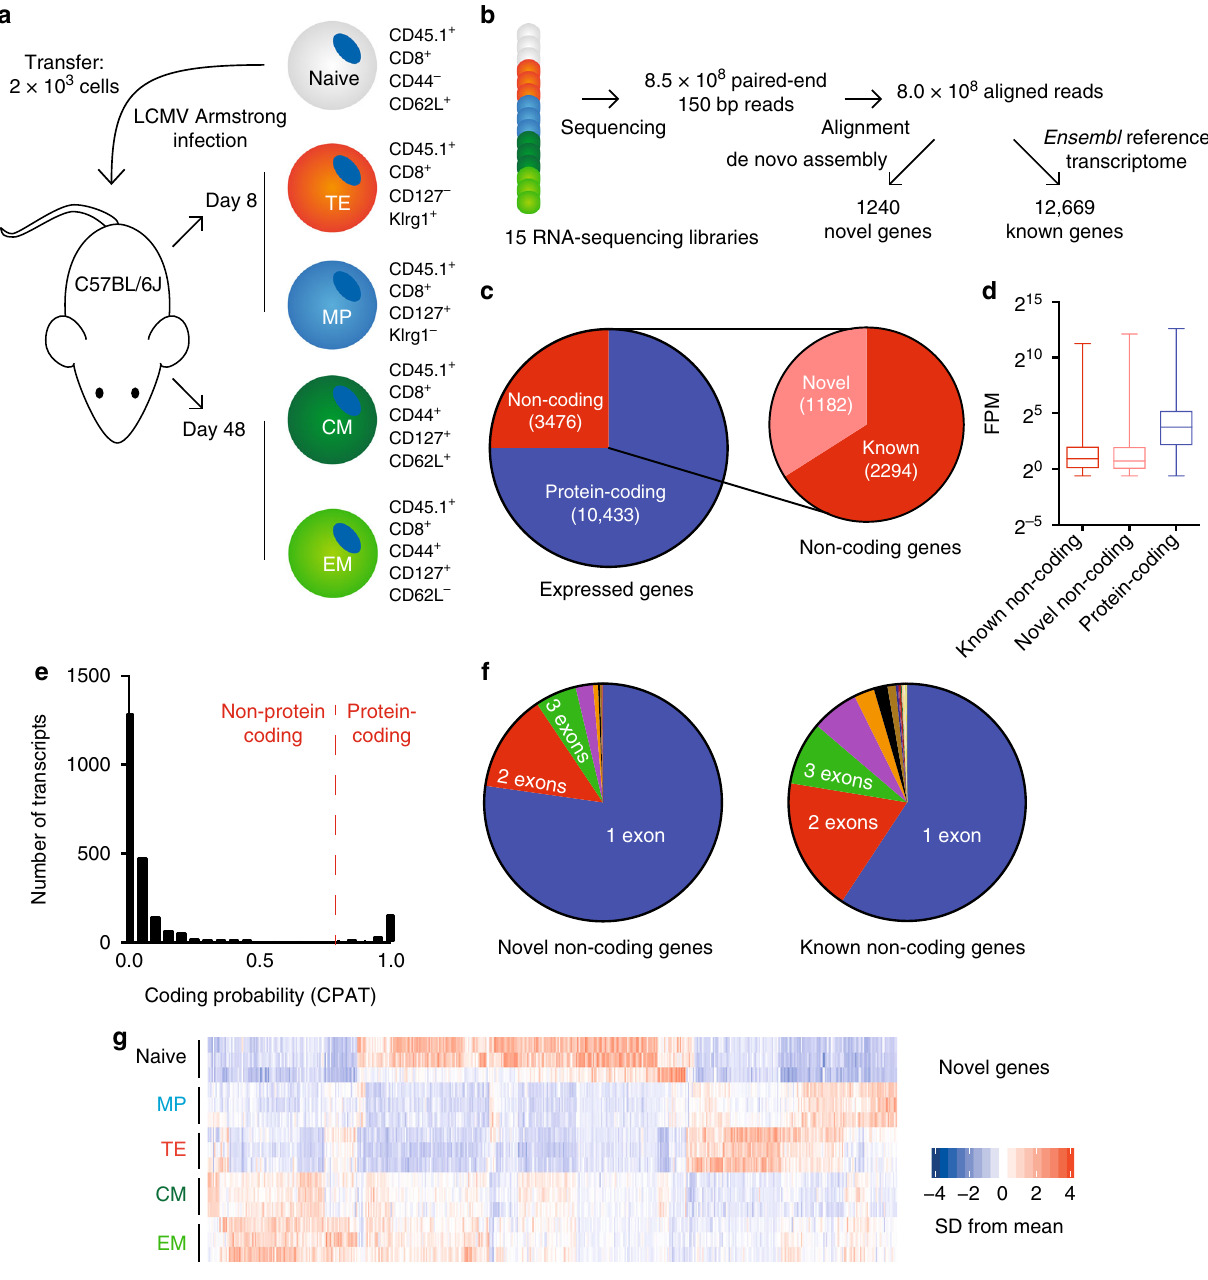
Fig. 1 Transcriptomic analysis of antigen-speci fi c mouse CD8 + T cells during acute infection. a 2000 naive CD45.1 + P14 cells were transferred to WT C57BL/6J mice that were subsequently infected with LCMV Armstrong. Eight and 48 days post-infection, indicated cell populations were isolated from splenocytes via FACS. At day 8, three pools of each cell type were isolated with three mice in each pool. At day 48, three pools of each cell type were isolated with fi ve mice in each pool. Separately, naive cells were isolated from three uninfected CD45.1 + P14 mice. b From these cell populations, RNA- sequencing libraries were generated and sequenced. Resulting sequences were aligned and analyzed for the expression of both reference and novel genes. c Types of genes expressed in antigen-speci fi c CD8 + T cells. d Average expression levels of types of genes from ( c ). e , f Protein-coding potential and exonic structure of the 1291 novel genes detected by de novo transcriptome assembly. g Heatmap of differentially expressed novel gene expression across all 15 samples. FPM, fragments per million. In panel ( d ), bars indicate minimum and maximum values and box indicates 25th percentile, median, and 75th percentile. FPM, fragments per million; SD, standard